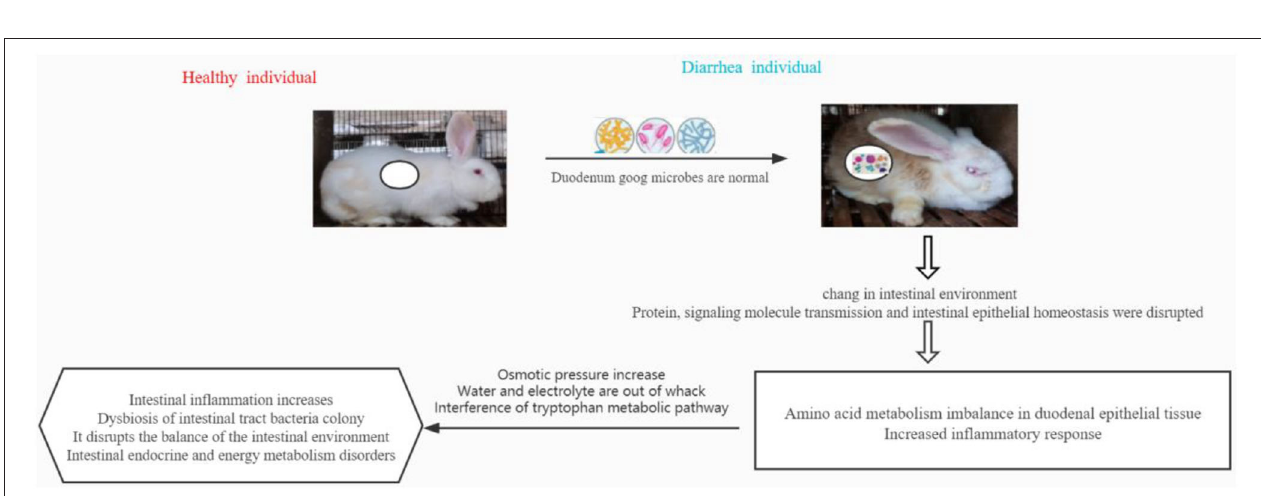
FIGURE 7 | Fecal microbial metabolism and gene expression. Compared with the CG, there was a significant correlation between duodenum intestinal microorganisms and metabolites in the EG (A) . Differential genes are involved in the main biochemical pathways and signal transduction pathways (B) . Blue, positive correlation; red, negative correlation. CG is the control group; EG is the experimental group; Beta Tran: data type, derived from metabolome or transcriptome analysis.